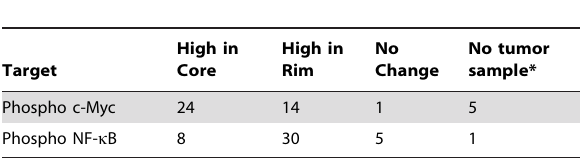
Table 1. Summary of comparative analysis of IHC staining for activated c-Myc and NF- k